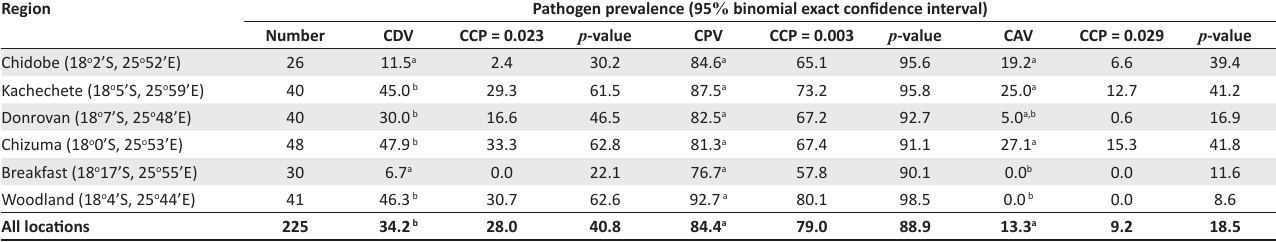
TABLE 1: Seroprevalence for selected pathogens in domestic dogs on communal lands in north-western Zimbabwe, 2012.